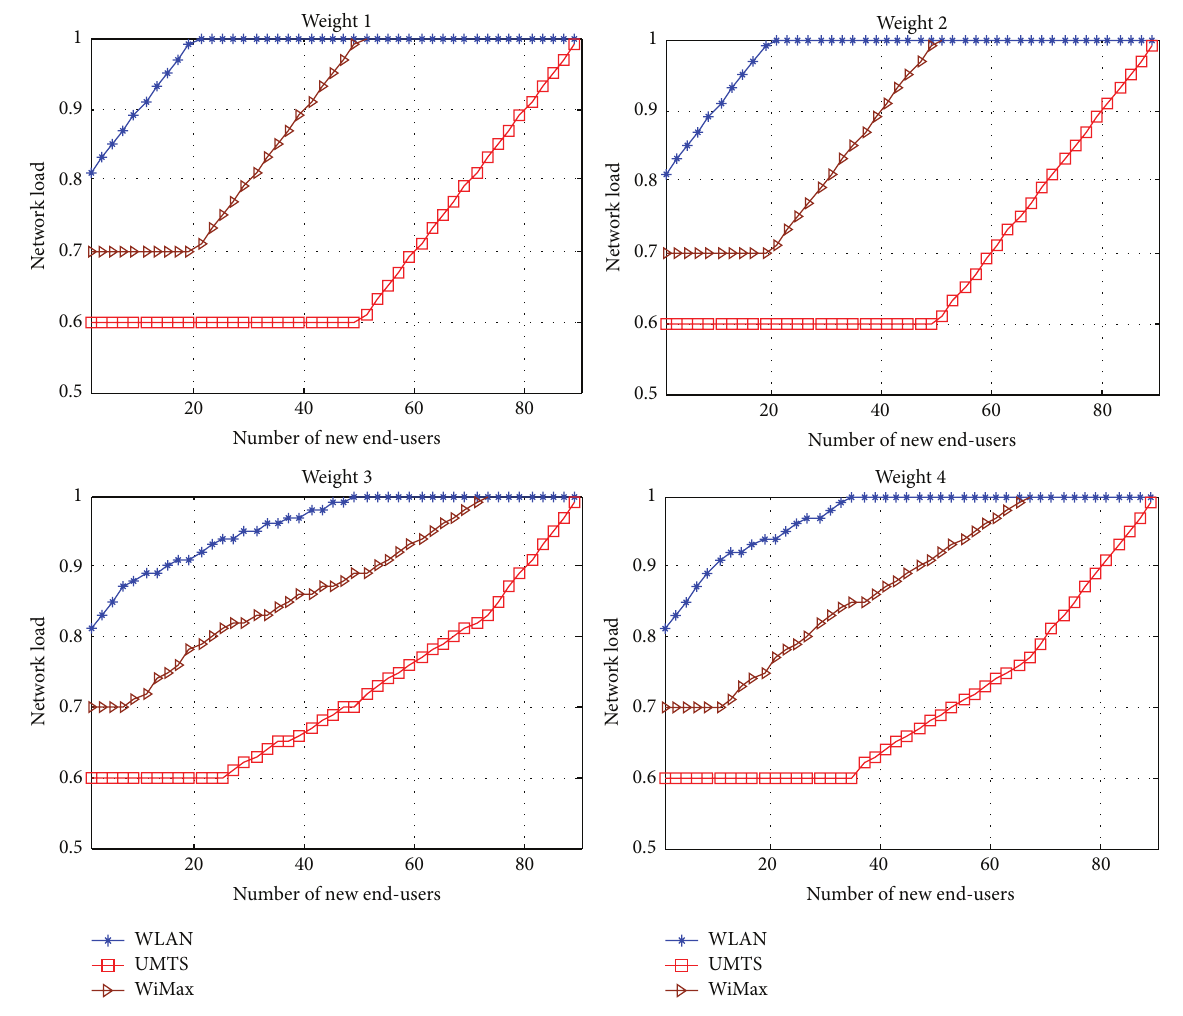
Figure 2: Change of network load by